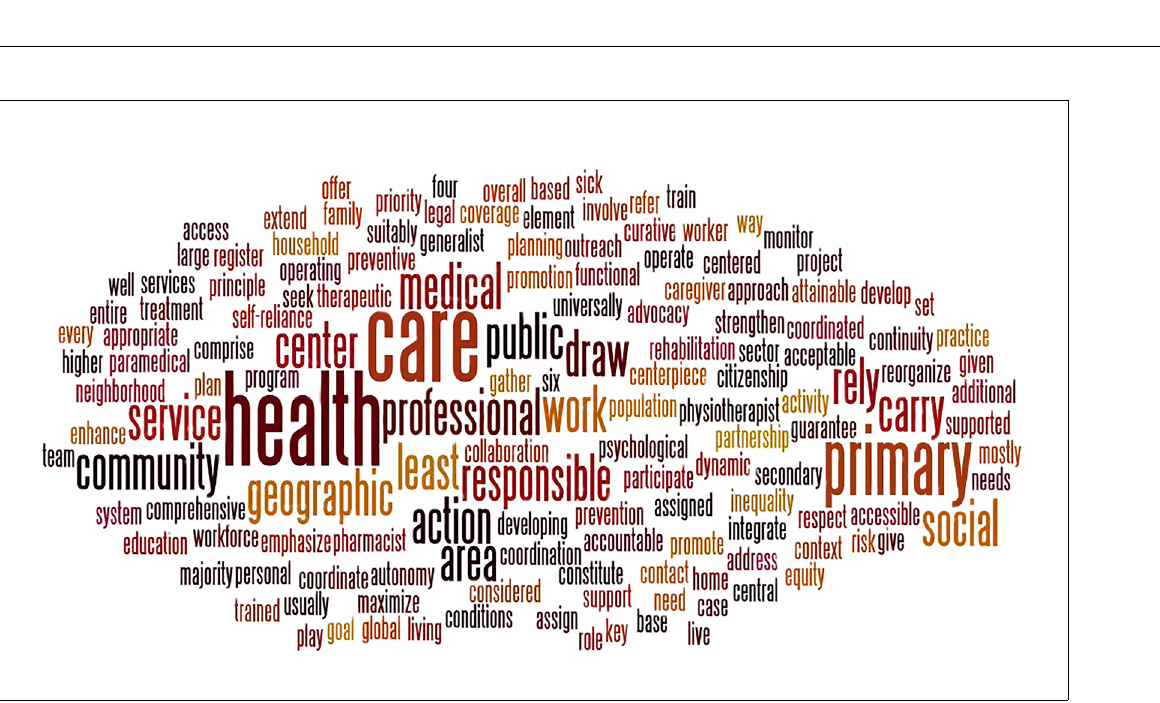
Figure 2. Tag cloud for Primary Health